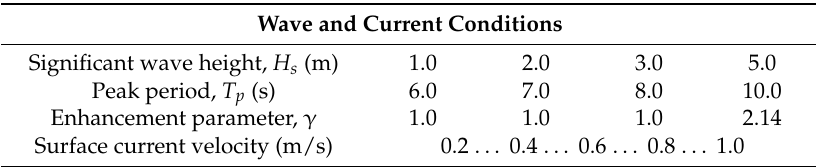
Table 2. Wave and current conditions for the parametric